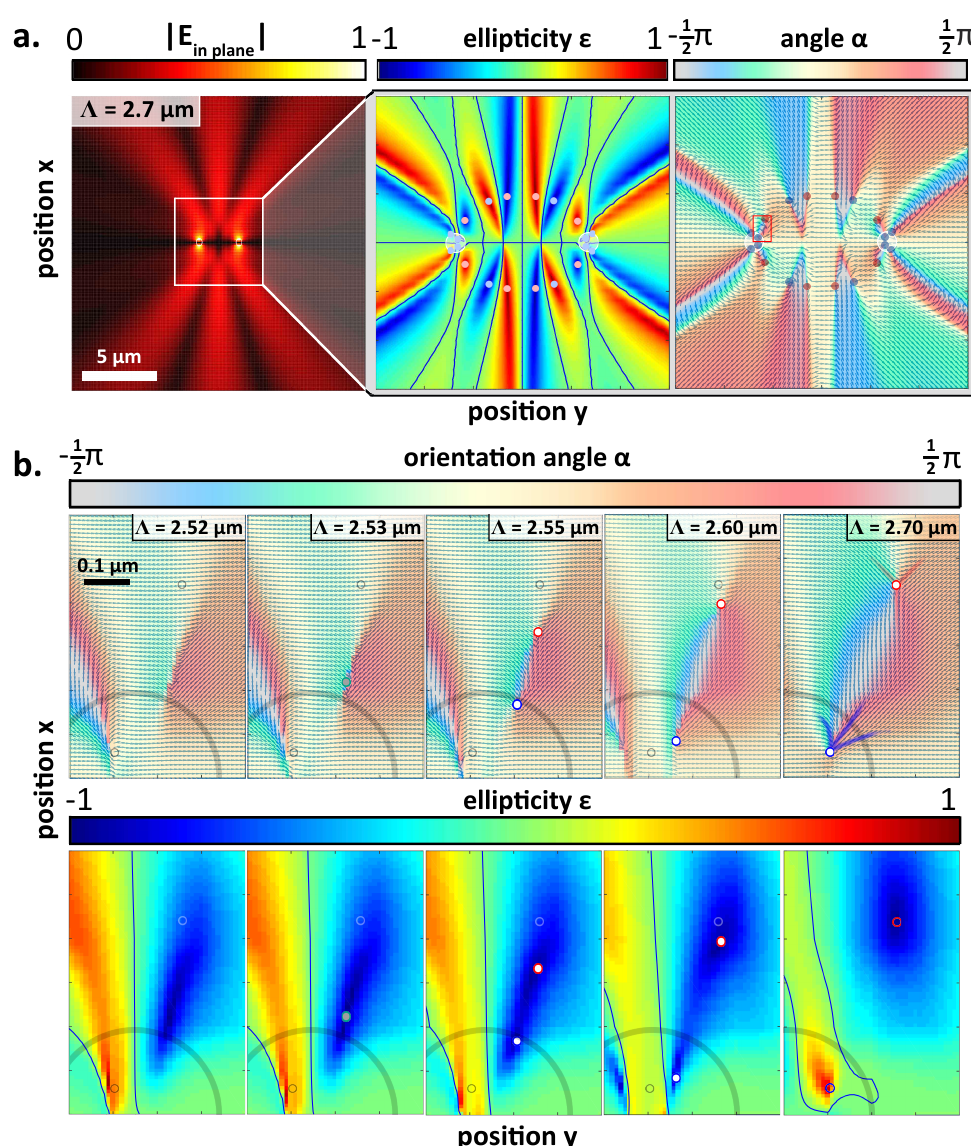
Figure 5. Evolution of the electric field leading to the creation of C-point pairs. ( a ) The in-plane electric field amplitude map, along with zoomed in maps of the ellipticity and orientation of the polarization ellipse, for two holes separated by 2.7 µ m, with initial inc excitation H . In the ε and α maps, we mark the locations of the C-points, and for α , x we also overlay the color map with vectors aligned along the direction of the long axis. Additionally, the region that contains the two C-points whose creation we investigate is marked in the α map. ( b ) The spatial evolution of ε and α for Λ = 2 . 52 to 2 . 70 µ m, in the region marked in (a). In all panes, we show the outlines of the holes, which scans through the field of view with the change to Λ . In all panes, we also show the final positions of the two C-points (for Λ = 2 . 7 µ m). For Λ = 2 . 53 µ m, we mark the location where changes in the α map herald the formation of the C-points, which we subsequently also mark for larger separations. Finally, for Λ = 2 . 70 , we also trace out the lines of constant α leading to the singularity, observing that the top C-point is a star singularity, while the bottom C-point is of the monstar